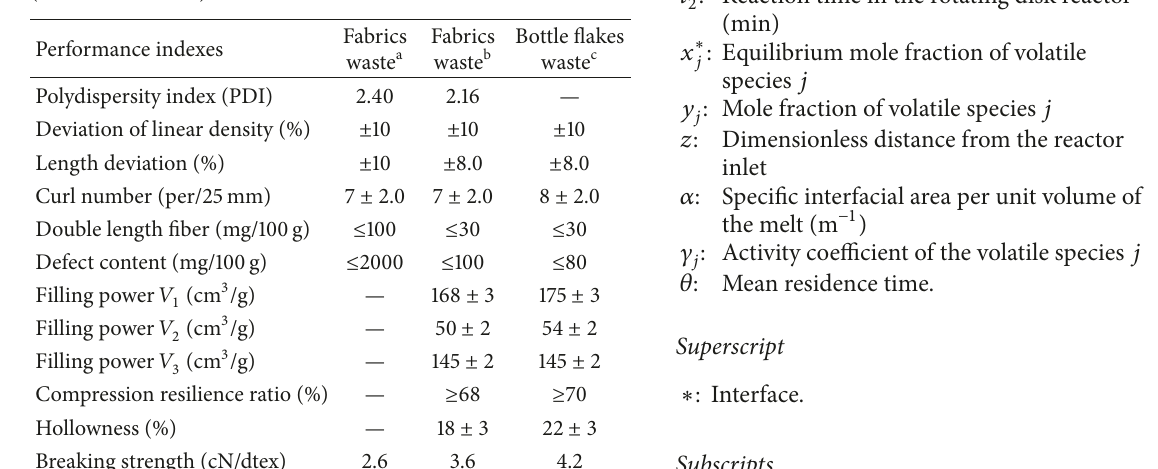
Table 5: Main performance indexes of recycled PET staple fiber (6.67 dtex ∗